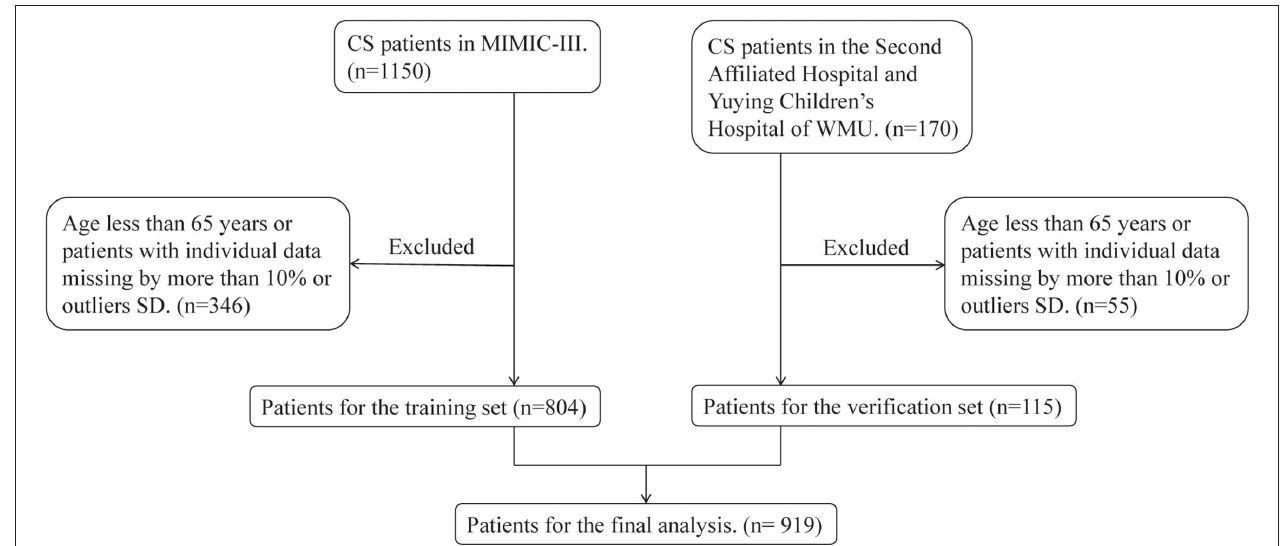
FIGURE 1 | Flowchart of patient